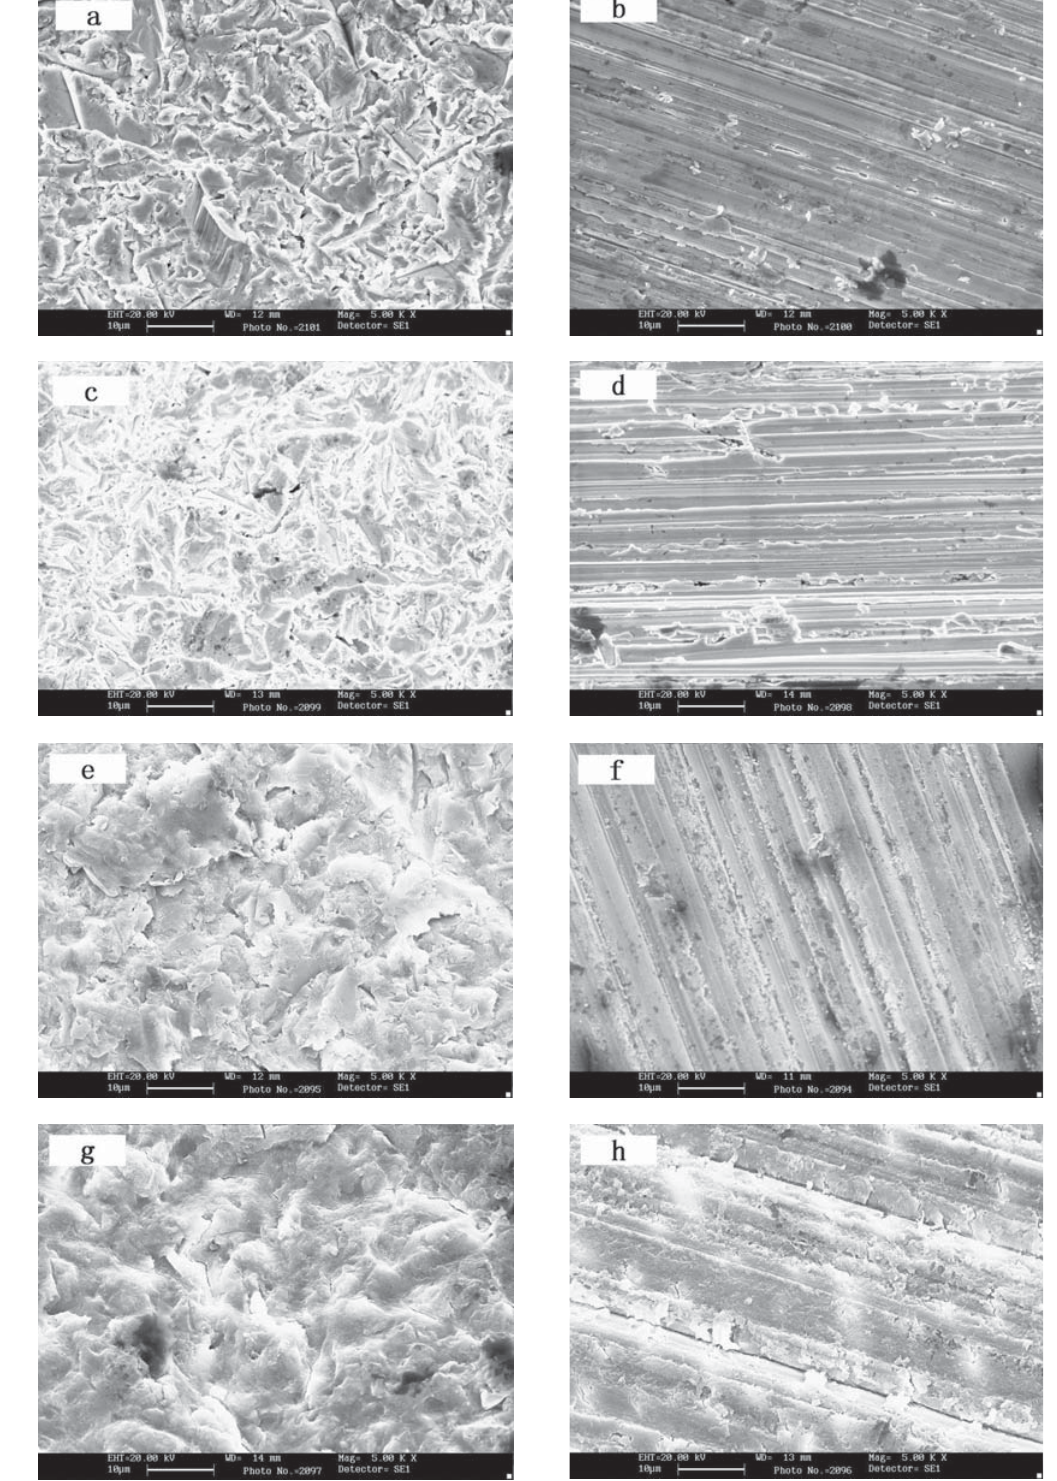
FIGURE 3- SEM images of bonding surfaces (x 5,000); (a) Nonprecious alloy treated with airborne-particle abrasion (Aa), (b) Nonprecious alloy treated with #1000 SiC abrasive paper (Sp), (c) Precious alloy treated with Aa, (d) Precious alloy treated with Sp, (e) Enamel treated with Aa, (f) Enamel treated with Sp, (g) Dentin treated with Aa, (h) Dentin treated with